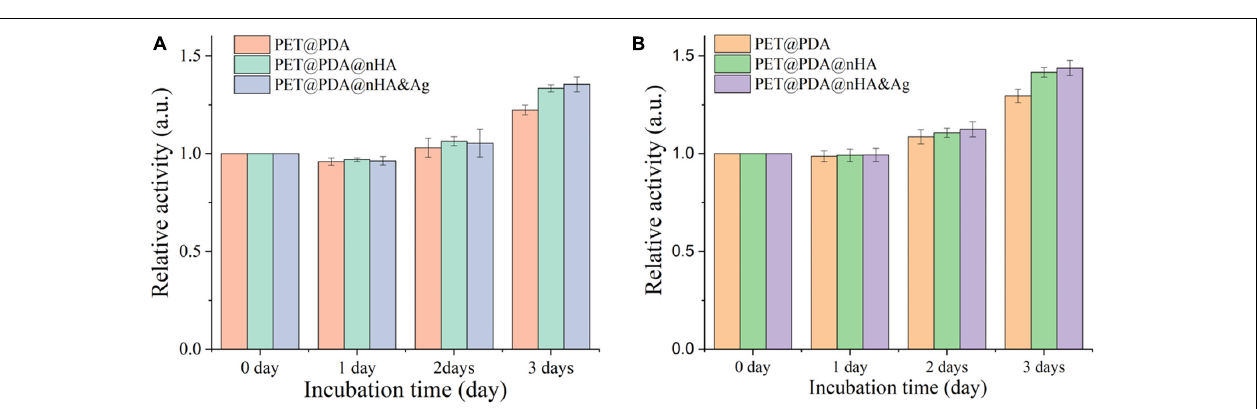
FIGURE 8 | (A) The release curve of silver ion of different ligaments, and (B) effect of Ag + reaction concentration on antibacterial ability.